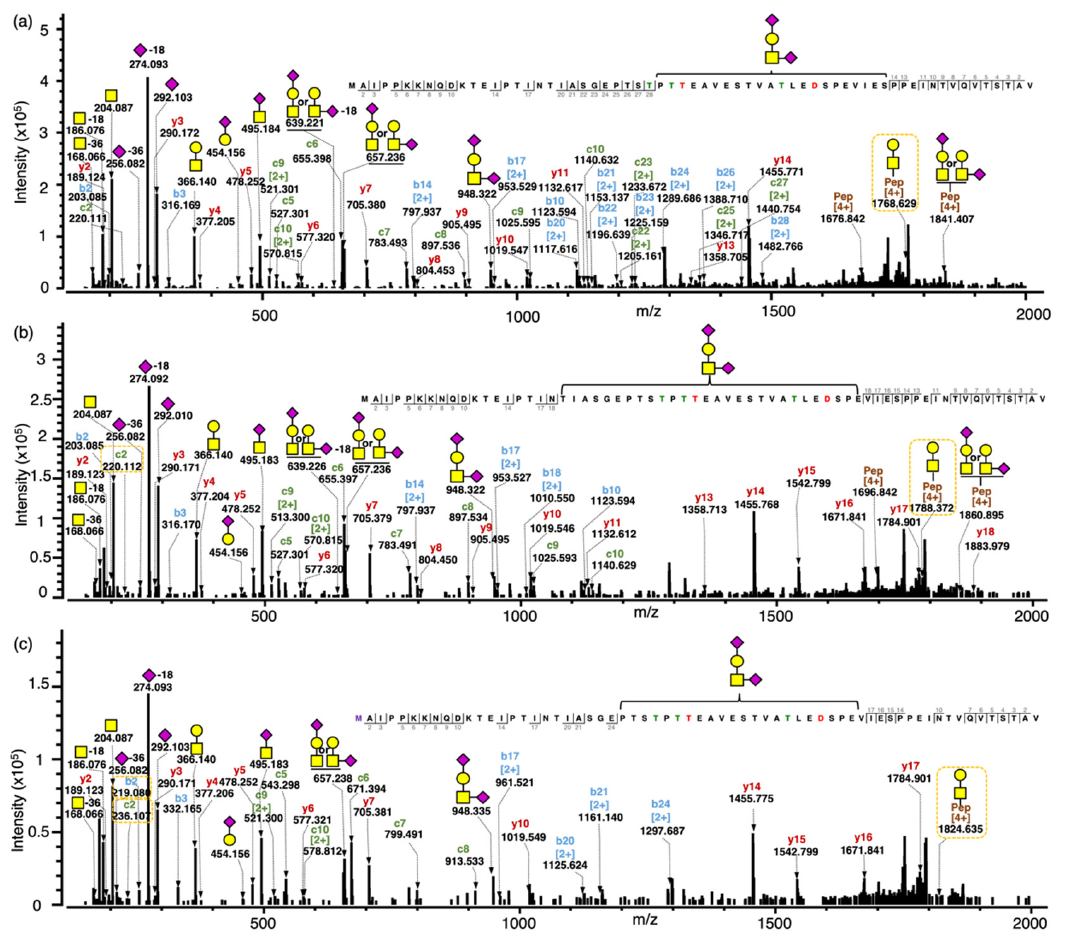
Figure 3. Annotated tandem MS spectra of intact CMPs with no, single or multiple modifications. ( a ) Tandem MS spectra for the intact gCMP with sequence CMP A containing one O -glycan (GalNAc 1 Gal 1 NeuAc 2 ) and one phosphate, observed m / z 1547.149 [M+5H] 5+ , scan time = 21.71 min found in the WPI sample; ( b ) Tandem MS spectra for the intact gCMP with sequence CMP A containing one O -glycan (GalNAc 1 Gal 1 NeuAc 2 ), one phosphate and one oxidation, observed m / z 1550.348 [M+5H] 5+ , scan time = 21.81 min found in the CMP powder 1 sample; ( c ) Tandem MS spectra for the intact gCMP with sequence CMP A containing one O -glycan (GalNAc 1 Gal 1 NeuAc 2 ), observed m / z 1531.151 [M+5H] 5+ , scan time = 21.98 min found in the CMP powder 1 sample. Glycan symbols: yellow square, N -acetyl galactosamine; yellow circle, galactose; and purple diamond, N -acetyl neuraminic acid.